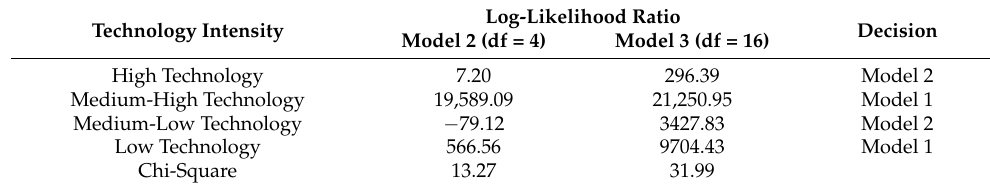
Table 4. Hypothesis testing of production